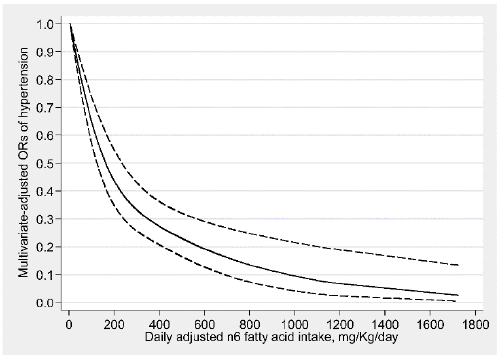
Figure 3. Dose-response relationship between n6 fatty acid intake and hypertension. The association was adjusted for age, gender, race, educational level, income, recreational activity, work activity, drinking status, smoking status, diabetes, and total energy intake. The solid line and dash line represent the estimated ORs and its 95% confidence intervals. (OR, odds ratio).